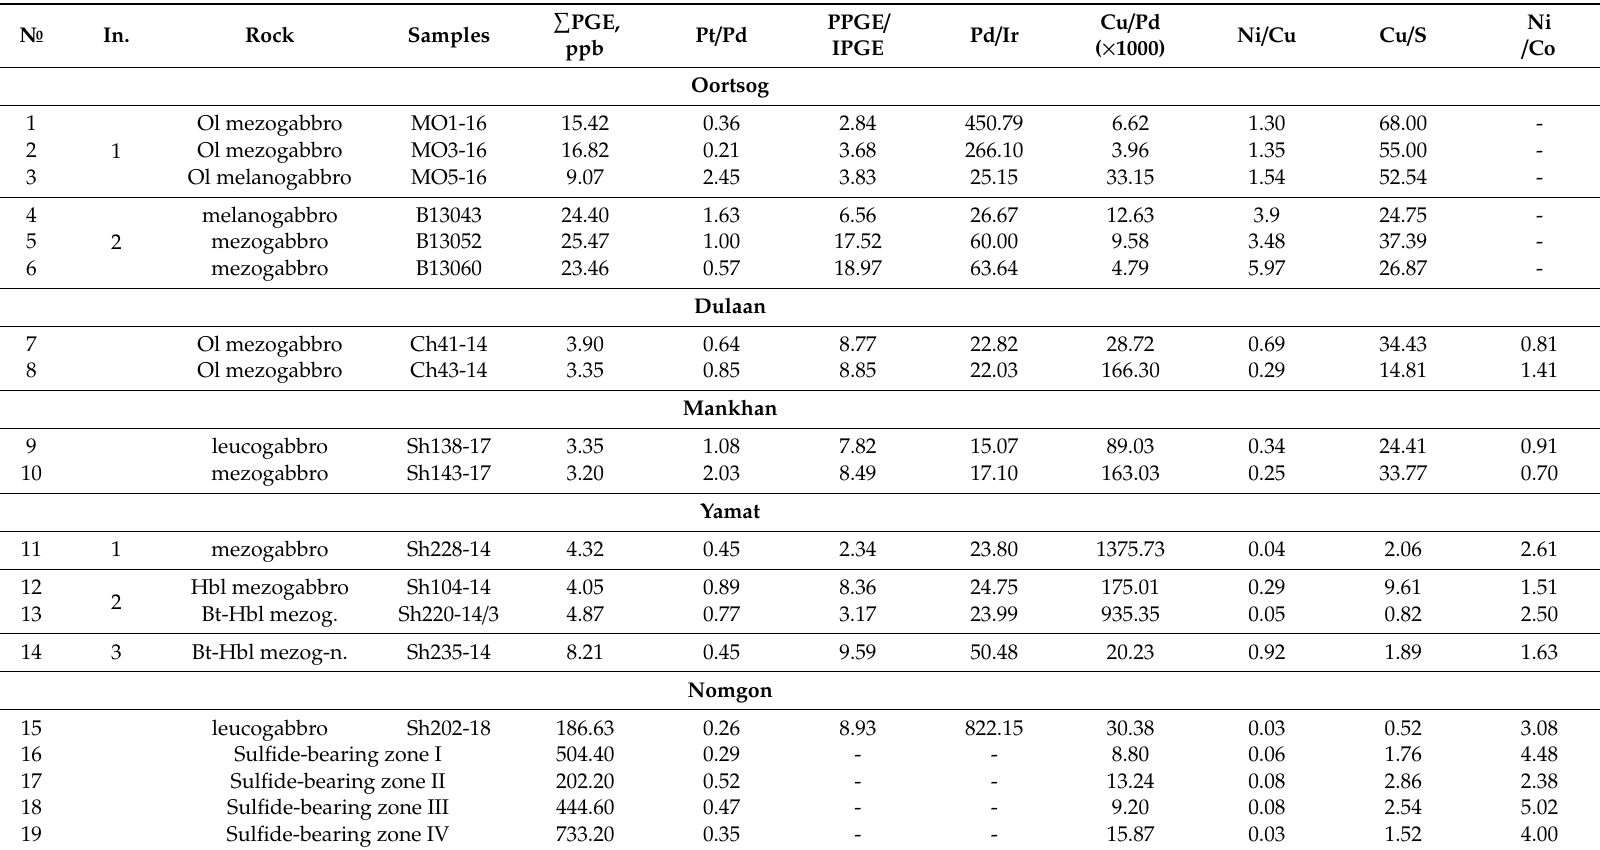
Table 5. Characteristics of sulfide-bearing rocks of mafic-ultramafic massifs of the Khangai